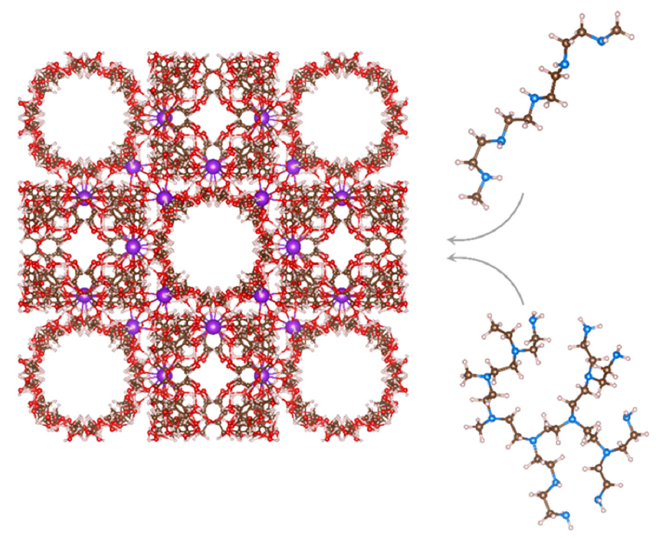
Figure 3. Schematic representation of encapsulation of linear and branched PEI in porous γ -CD MOF structure. Atoms of H, C, O, N and K are shown as pink, brown, red, blue and purple, respec- tively.